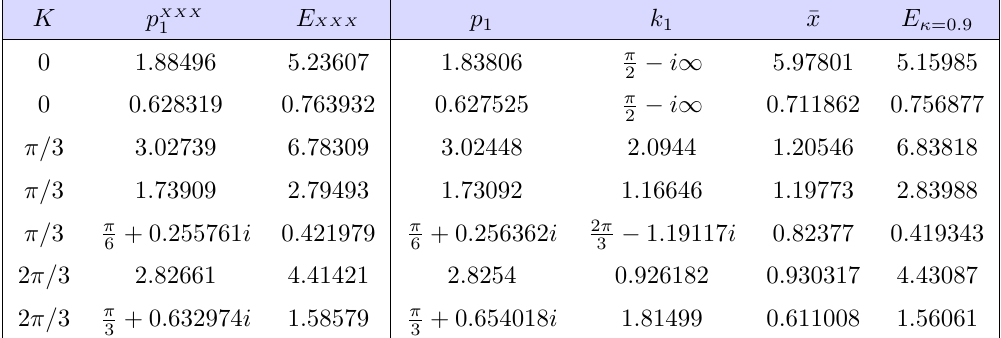
momenta can be 2 , k 2